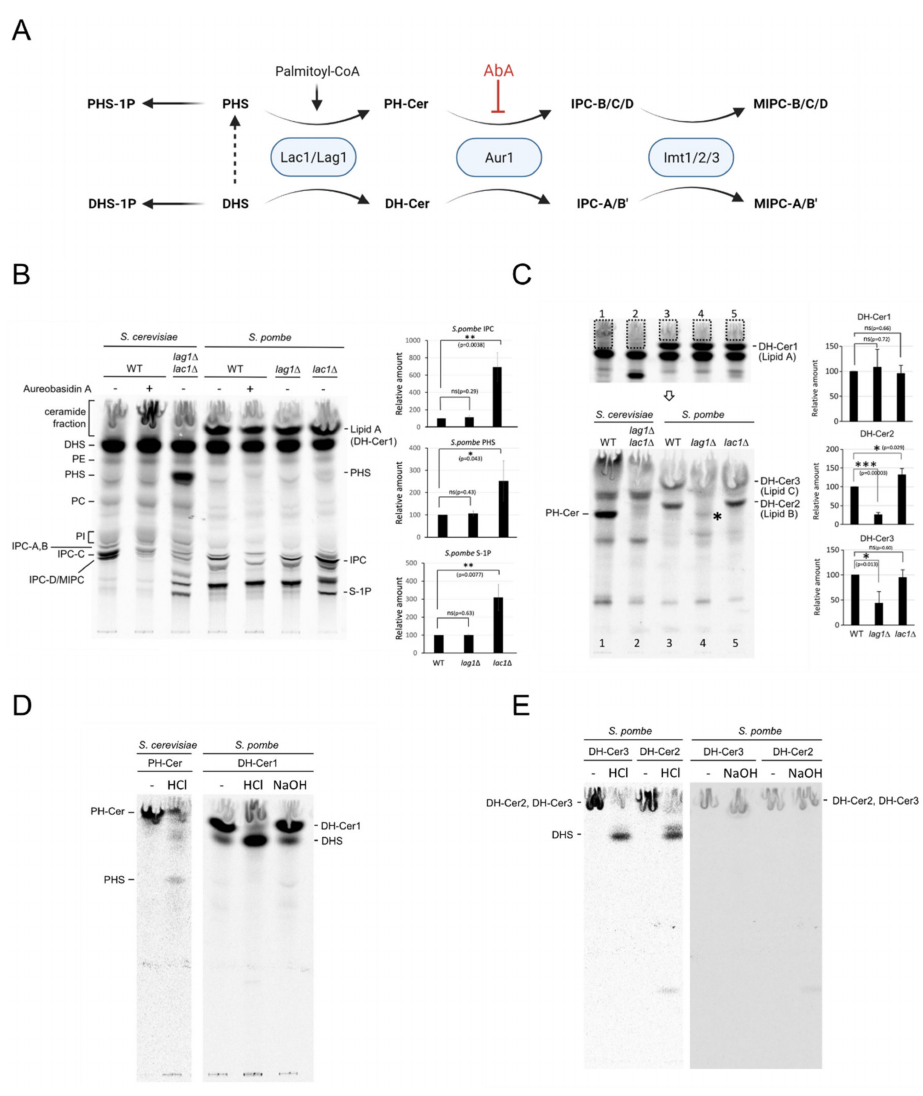
Figure 5. Lipid analysis in lac1 ∆ and lag1 ∆ cells. ( A ) Summary of sphingolipid synthesis pathway. Small-molecule inhibitor aureobasidin A is indicated in red. DHS, dihydrosphingosine; PHS, phy- tosphingosine; DHS-P/ PHS-P, dihydrosphingosine/phytosphingosine-1-phosphate; IPC-A, -B, -C and –D, inositolphosphorylceramide subclasses A, B, C and D; MIPC, mannosylinositolphospho- rylceramide. ( B – D ) Wild-type and mutant cells were labeled with [ 3 H] dihydrosphingosine (DHS) at 25 ◦ C for 2 h, in the absence or presence of 2 µ g/mL aureobasidin A. The labeled lipids were extracted and analyzed by thin-layer chromatography (TLC), using solvent system I (( B , C ), upper). * Denotes (in ( C )) putative PH-Cer in S. pombe lag1 ∆ . Fractions containing ceramides in ( C ) upper were collected by scraping silica gels; extracted with a mixture of chloroform–methanol; and analyzed by TLC, using solvent system II ( C , lower). Phytoceramide (PH-Cer) and dihydroceramides (DH-Cer2 and DH-Cer3) were purified from the TLC plate in C lower, and DH-Cer1 was purified from ( C ) upper. They were subjected to strong HCl hydrolysis or mild alkaline hydrolysis with NaOH and analyzed by TLC, using solvent system I ( D , E ). Incorporation of [ 3 H] DHS into IPC ( B ) and DH-Cer ( C ) was quantified, and the relative amounts were determined as the percentage of the incorporation in wild-type cells. Data represent mean ± SD of three independent experiments; * p < 0.05, ** p < 0.01 and *** p < 0.001 by Student’s t -test. PE, phosphatidylethanolamine; PHS, phytosphingosine; PC, phosphatidylcholine; PI, phosphatidylinositol; IPC-A, -B, -C and -D, inositolphosphorylceramide subclasses A, B, C and D; MIPC, mannosylinositolphosphorylceramide; PH-Cer, DH-Cer1(lipid A), DH-Cer2 (lipid B), DH-Cer3 (lipid C), different ceramide species, S-1P, sphingoid